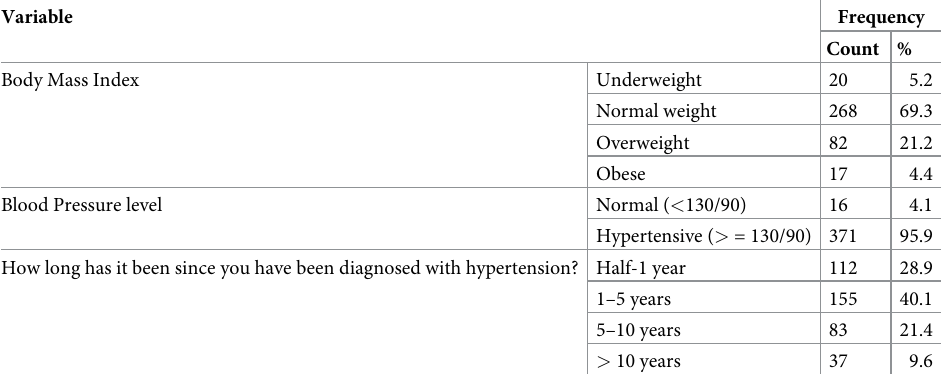
Table 3. Clinical characteristics of hypertensive patients on treatment follow up regarding lifestyle modification at Yekatit 12 General hospital in 2019 (n =